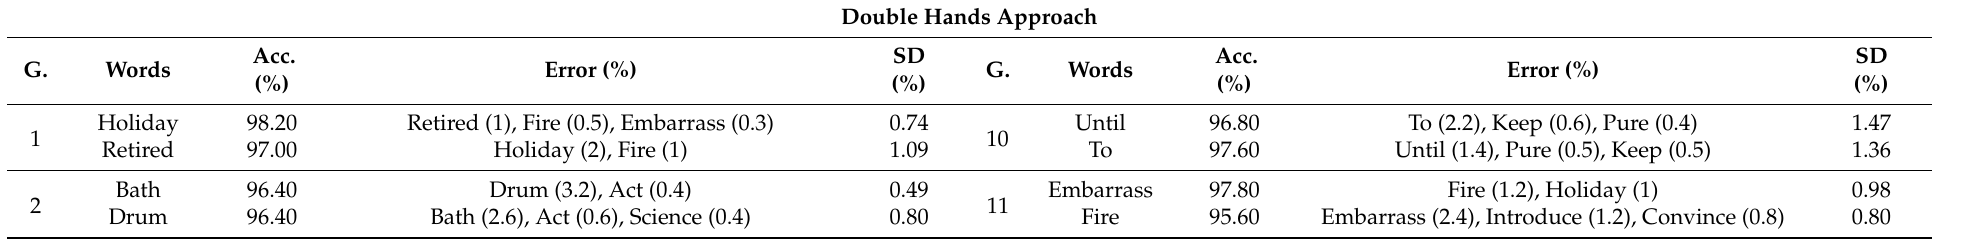
Table 11. Signed-word recognition based on double-hand data based on a backhand view and using 5-fold cross validation. Double Hands